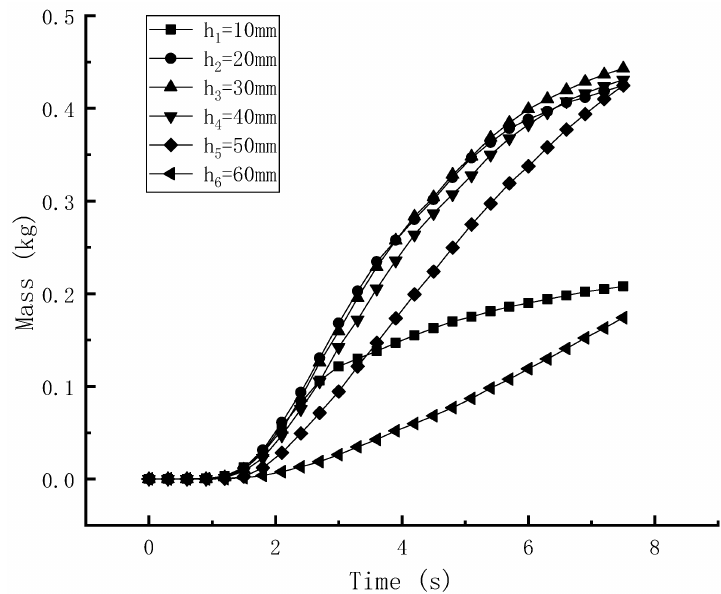
Figure 8. Change curves of rice-filling quality with different heights of rice filling.